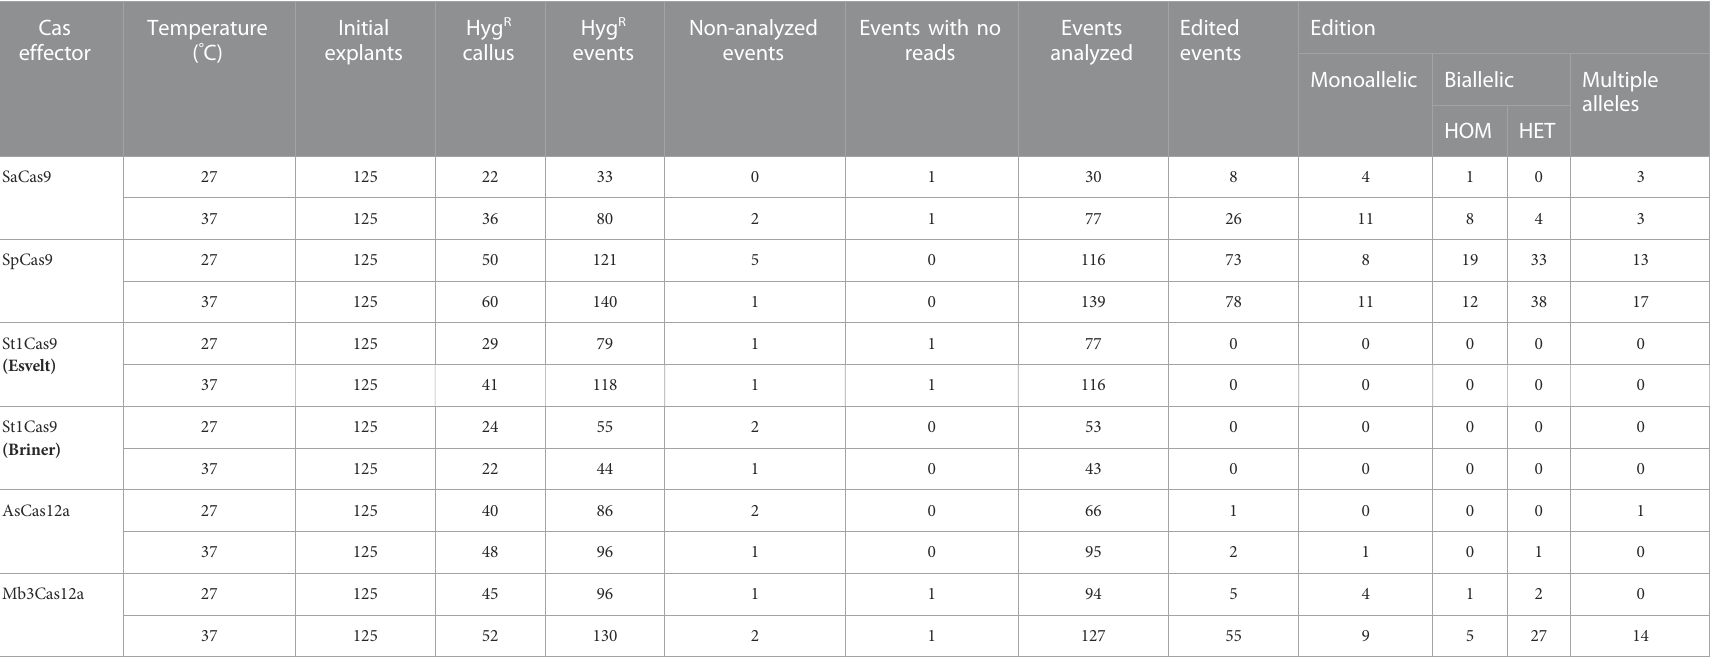
TABLE 1 Molecular analyses of OsPDS alleles in rice embryogenic calli exposed to heat